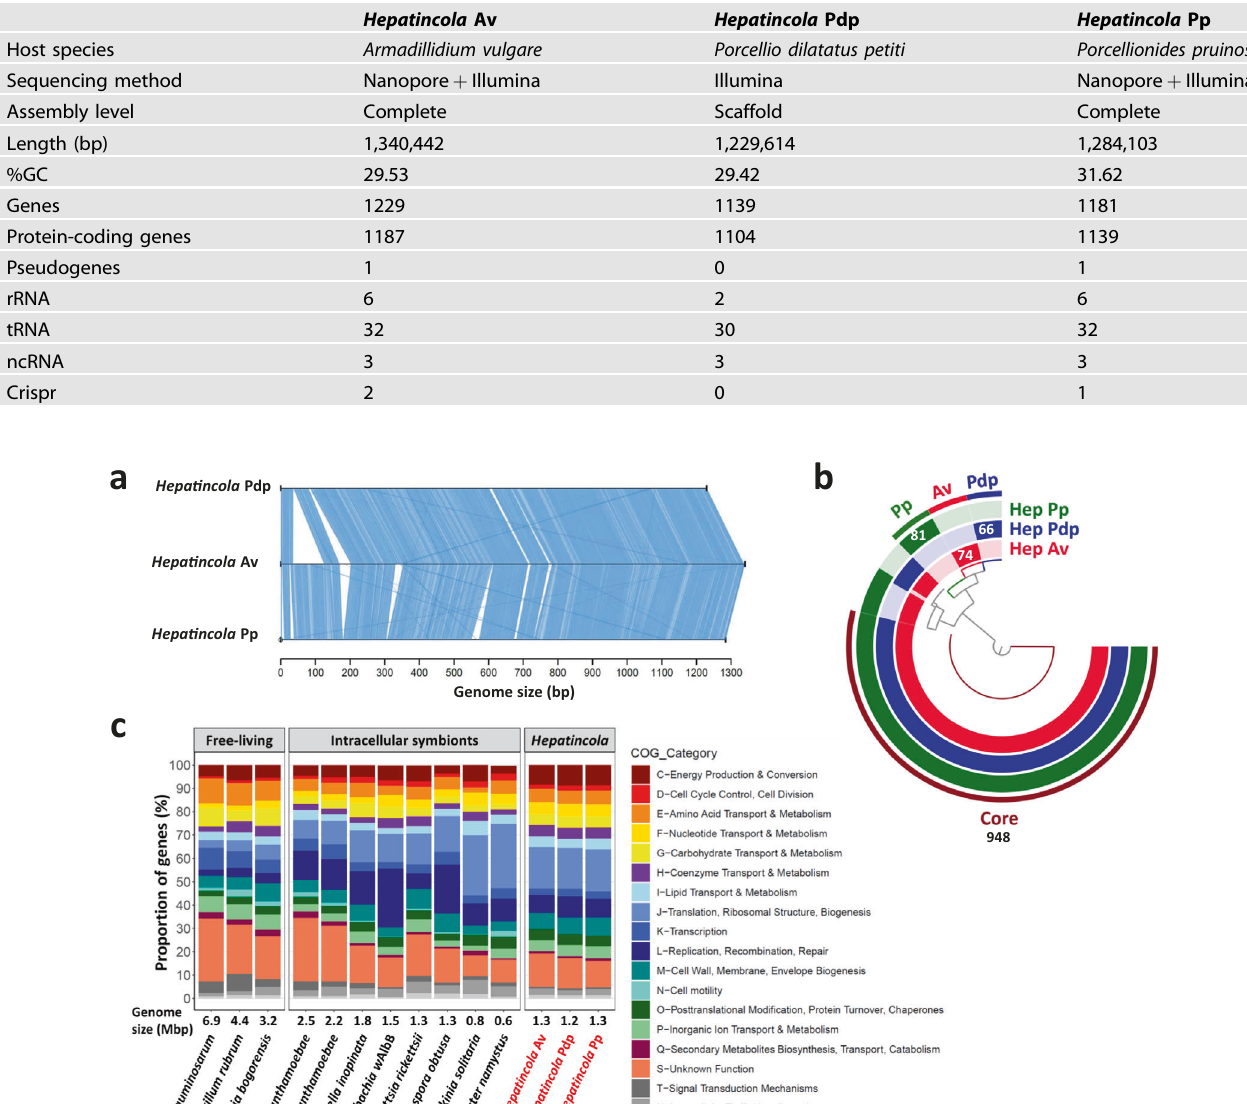
Table 2. Properties of the three Hepatincola genomes.